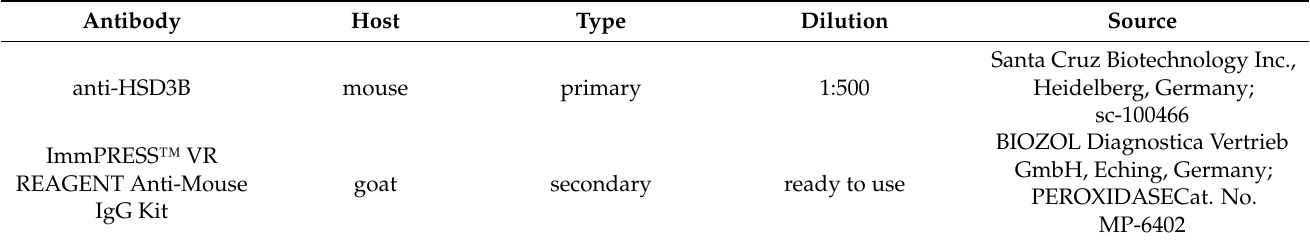
Table 2. Description of primary and secondary antibodies used for